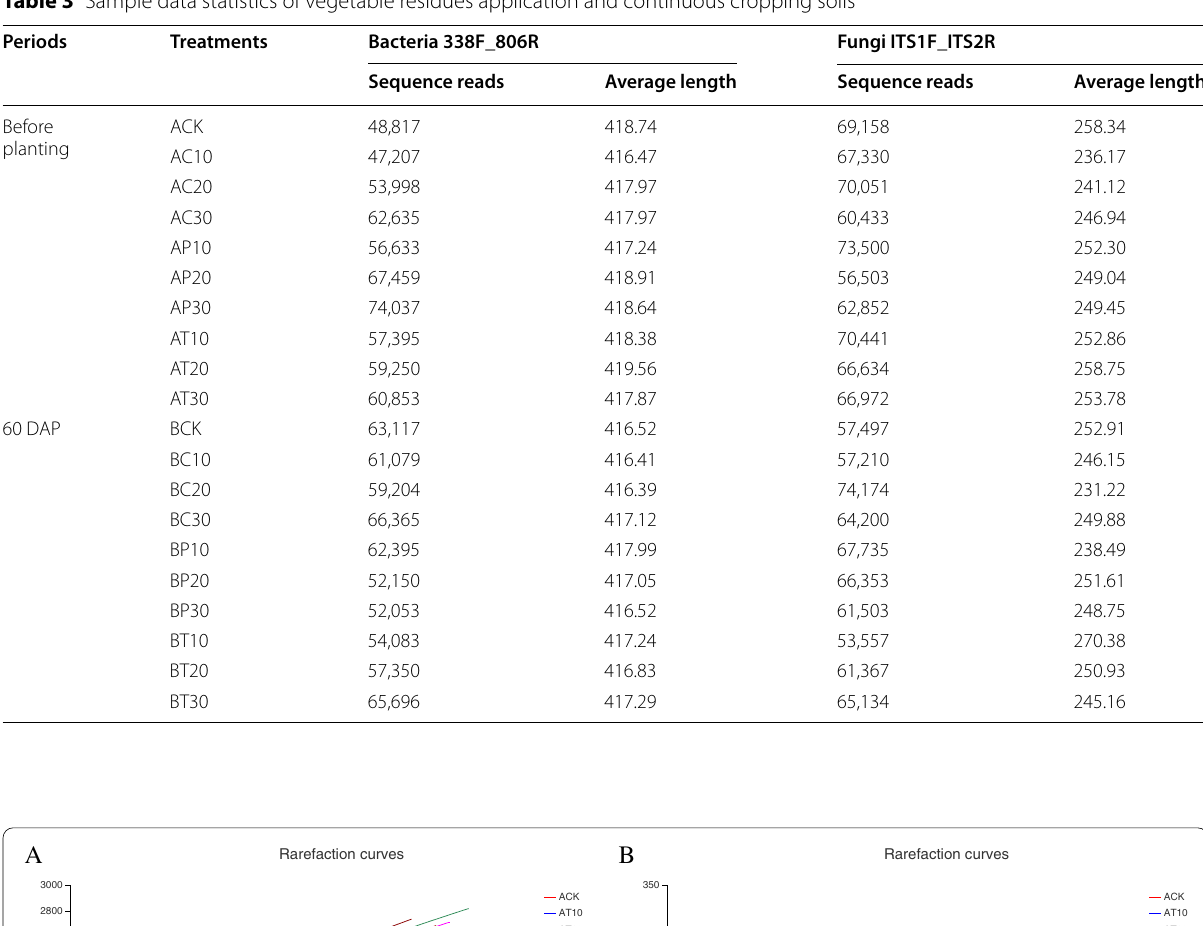
The contribution of the 1st and 2nd principal compo- nents of PCoA on the fungal communities was 67.33%, 13.92%, 82.42%, and 8.43%, respectively. These results indicated that all principal coordinates selected in PcoA